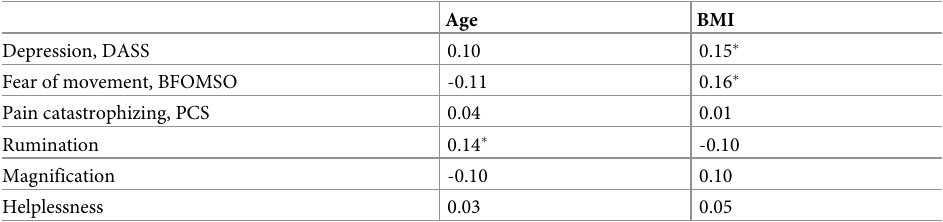
Table 2. Correlation between age and BMI, and psychological